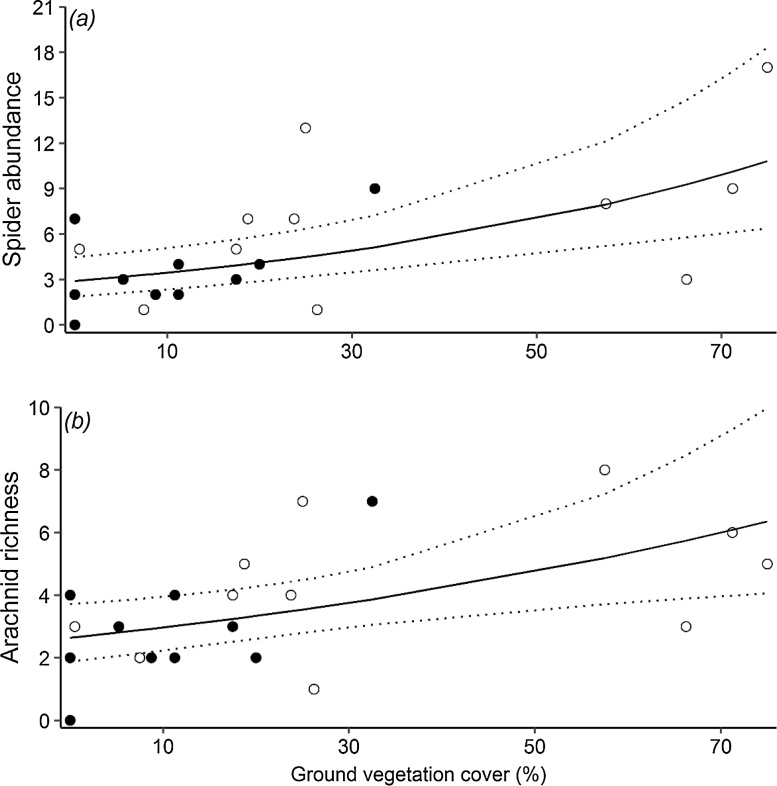
Effects of the proportion of ground vegetation cover on (a) spider abundance and (b) arachnid species richness in vineyards. Model predictions are represented by the black solid lines with 95% confidence interval indicated by the dotted lines. Open circles, organically-managed vineyards; filled circles: conventionally-managed vineyards.